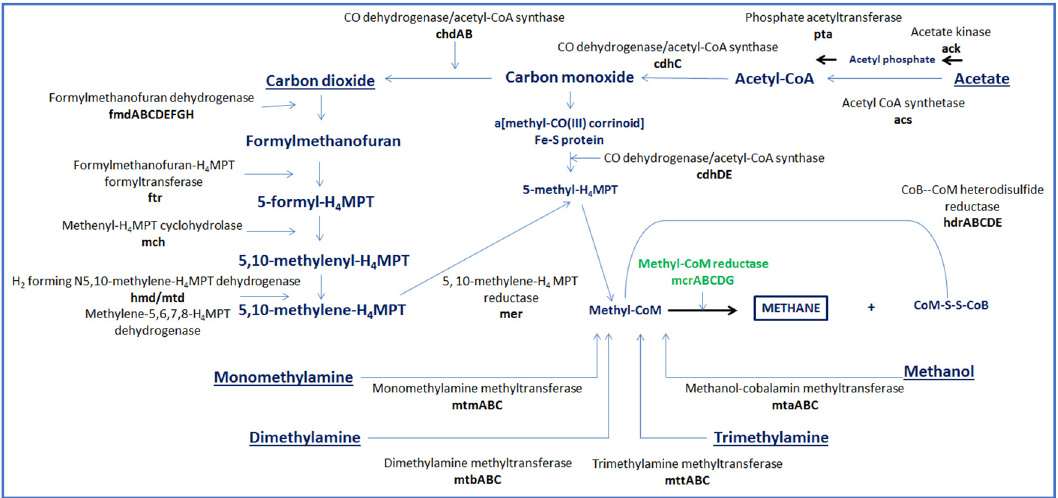
Figure 1. Schematic representation of methanogenesis pathways from carbon dioxide (hydrogenotrophic), acetate (acetoclastic), and mono, di-, tri- methylamine and methanol (methotrophic)